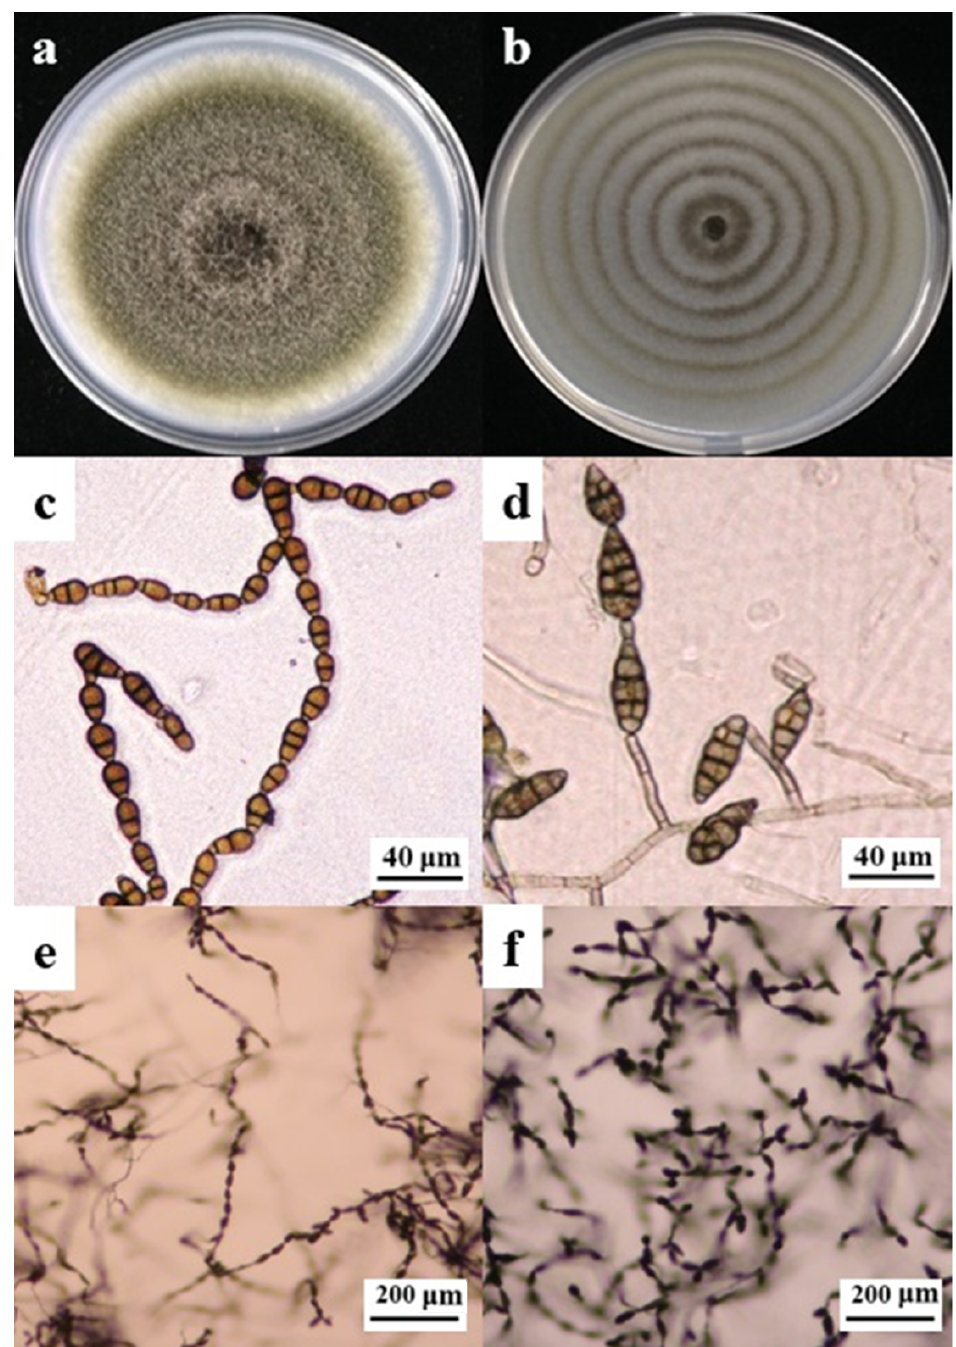
Figure 1. Morphology of the representative isolates of Alternaria tenuissima and A. alternata . ( a ): col- onies of A. tenuissima ; ( b ): colonies of A. alternata ; ( c ): conidia of A. tenuissima ; ( d ): conidia of A. alternata ; ( e ): sporulation pa tt erns of A. tenuissima ; ( f ): sporulation pa tt erns of A. alternata .